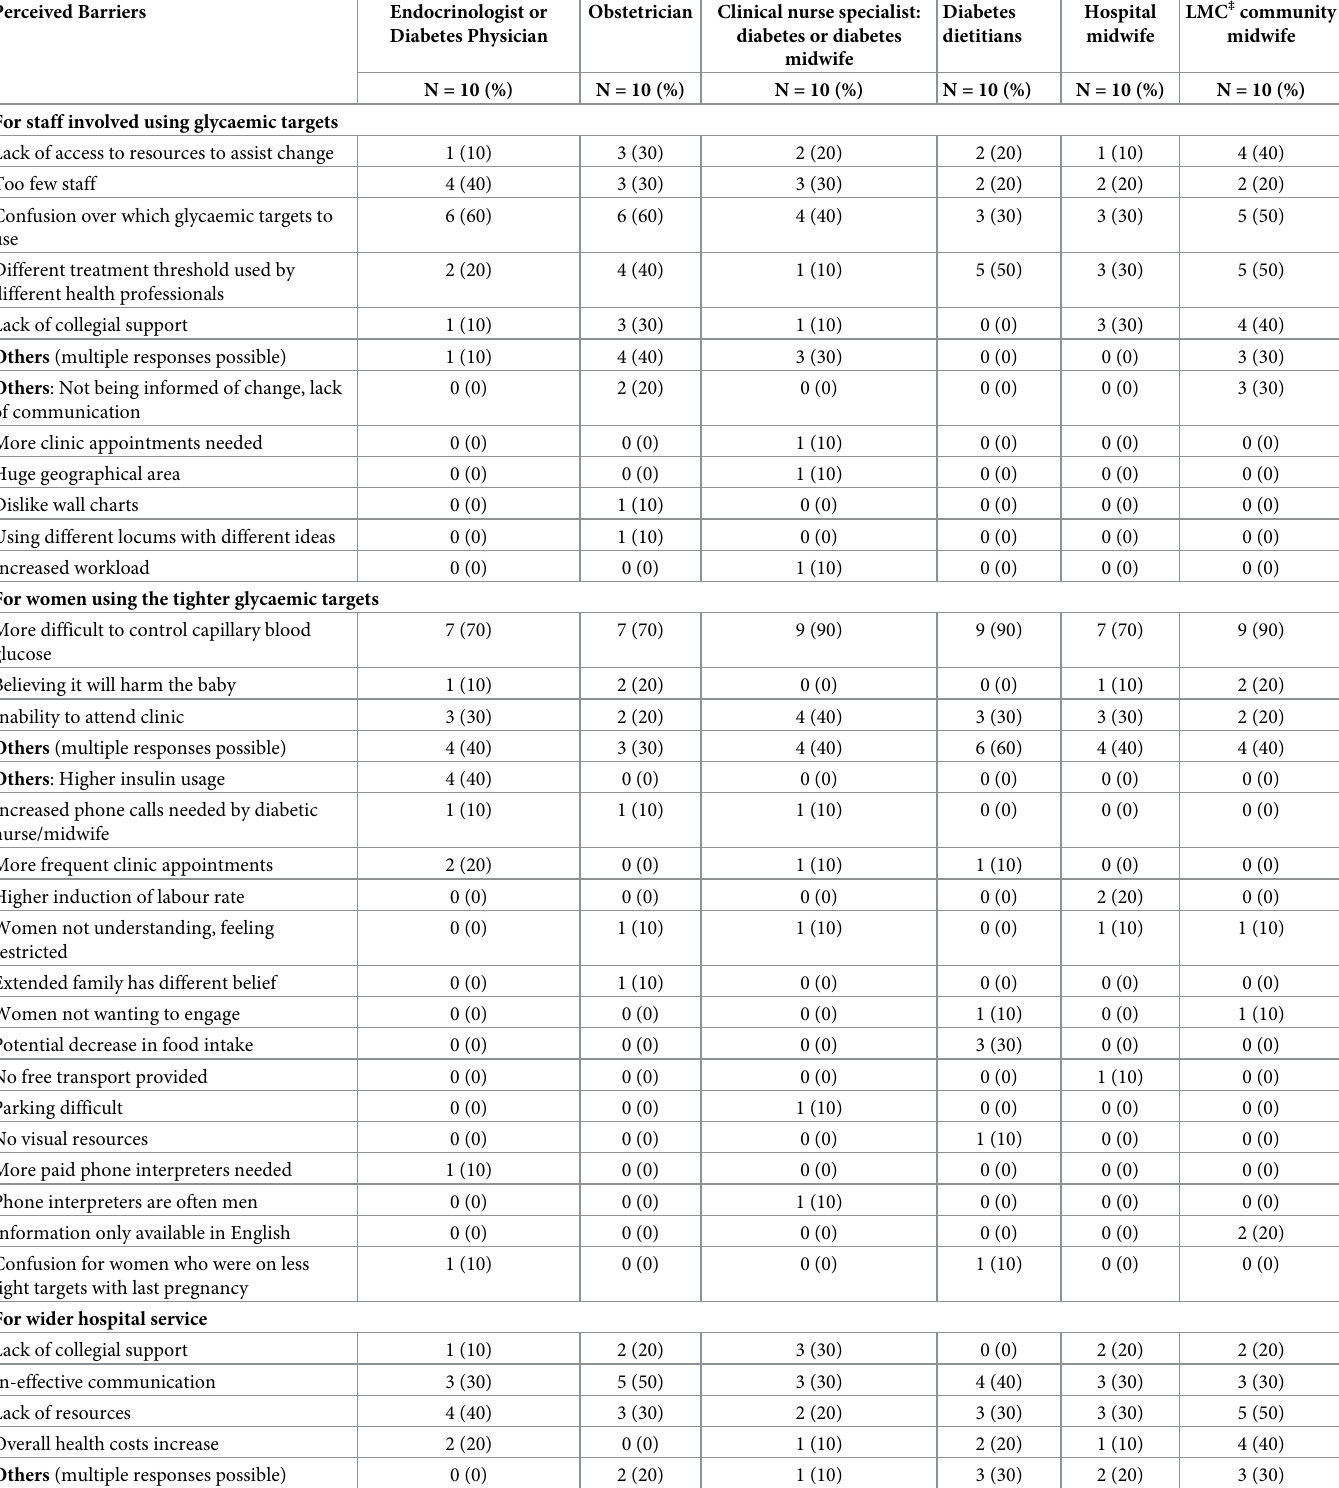
Table 5. Differences of barrier perception prior to implementing tighter glycaemic targets between Key Informant Health Professionals’ groups # . Perceived